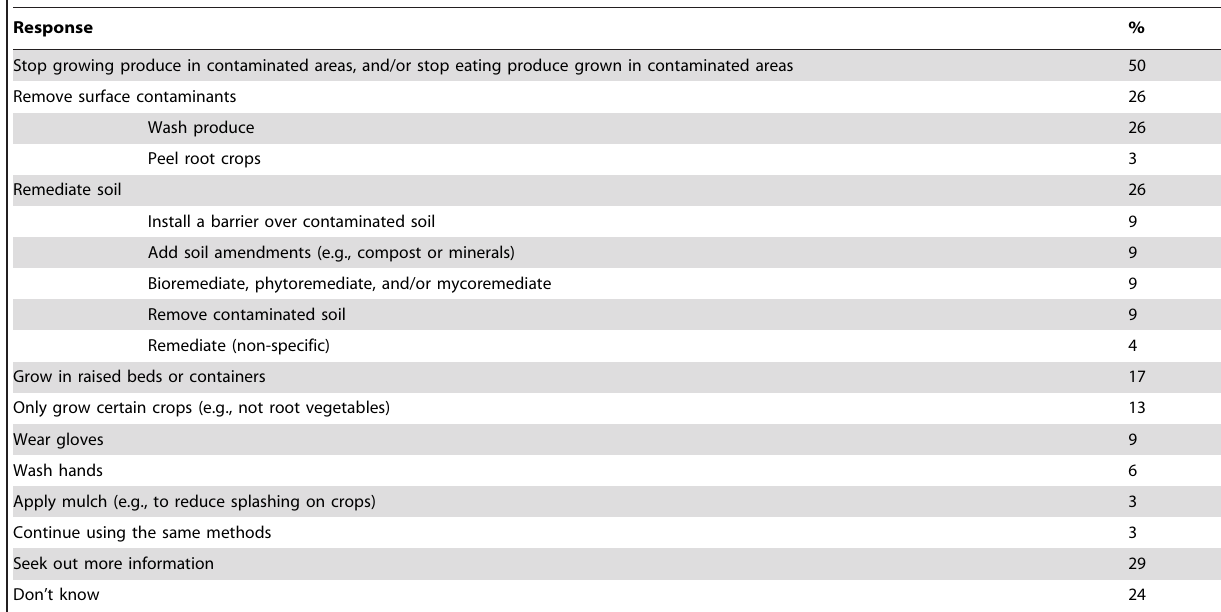
Table 4. Open-ended responses to questions about reducing exposure in contaminated environments.